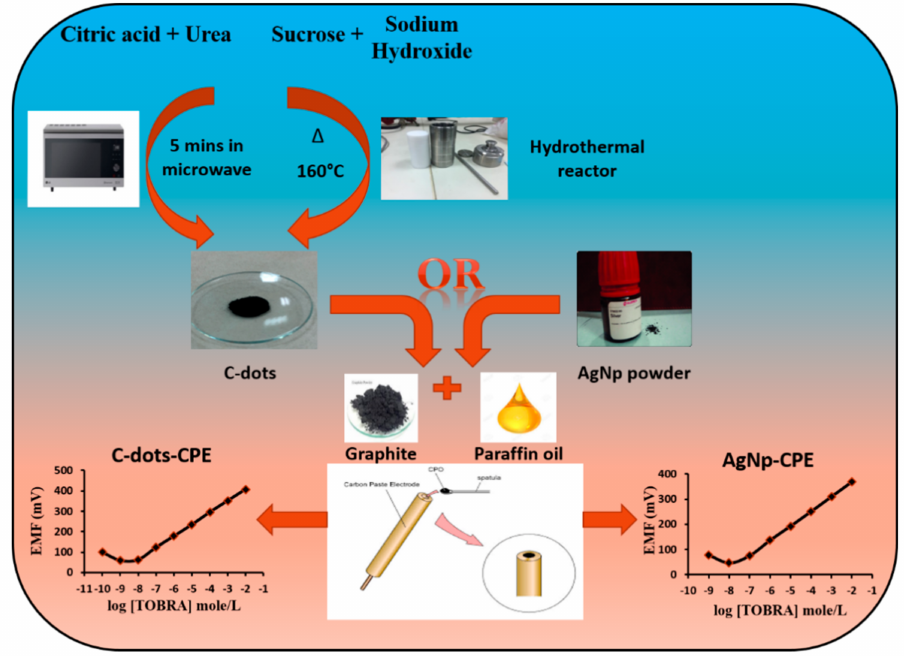
Figure 7. Schematic illustration of the preparation of N-CQDs by a microwave-assisted method. Car- bon paste electrode was modified with N-CQDs for the potentiometric determination of tobramycin sulfate in pharmaceutical formulation and spiked human plasma. Reprinted from Ref.